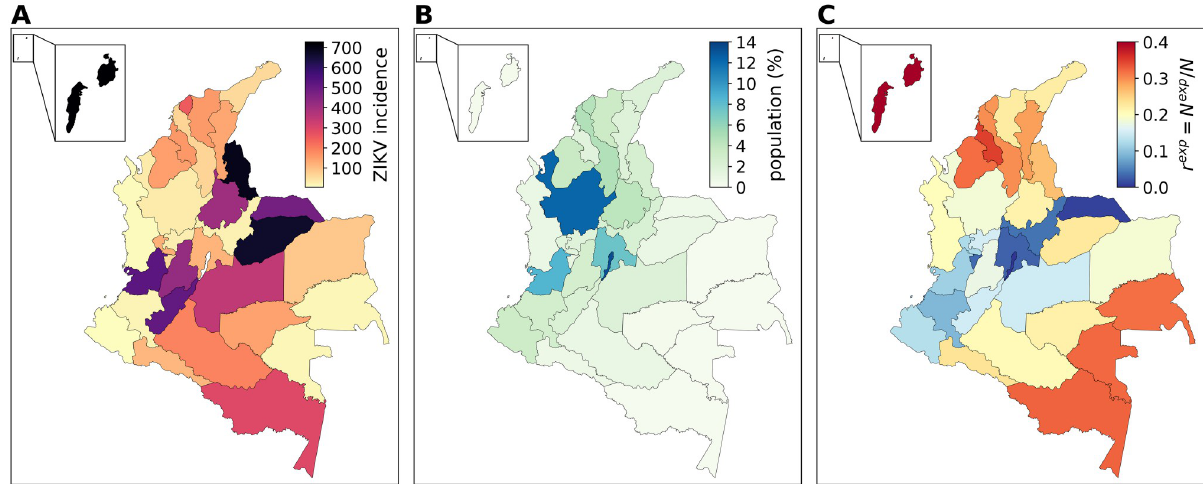
Fig 1. Data layers by Colombian department. (A) Cumulative ZIKV incidence (per 100,000 population) reported by Colombia’s National Institute of Health in the period from October 4, 2015 (epidemiological week 2015–40) to October 2, 2016 (epidemiological week 2016–40). (B) Population estimates by department. Population is mainly concentrated in the northern and western part of the country, where most of the urban centres are located, whereas the southern and eastern parts of Colombia are mostly sparsely inhabited. (C) Fraction of population exposed to ZIKV due to environmental and socio-economic conditions (more details in Section 3.1 in S1